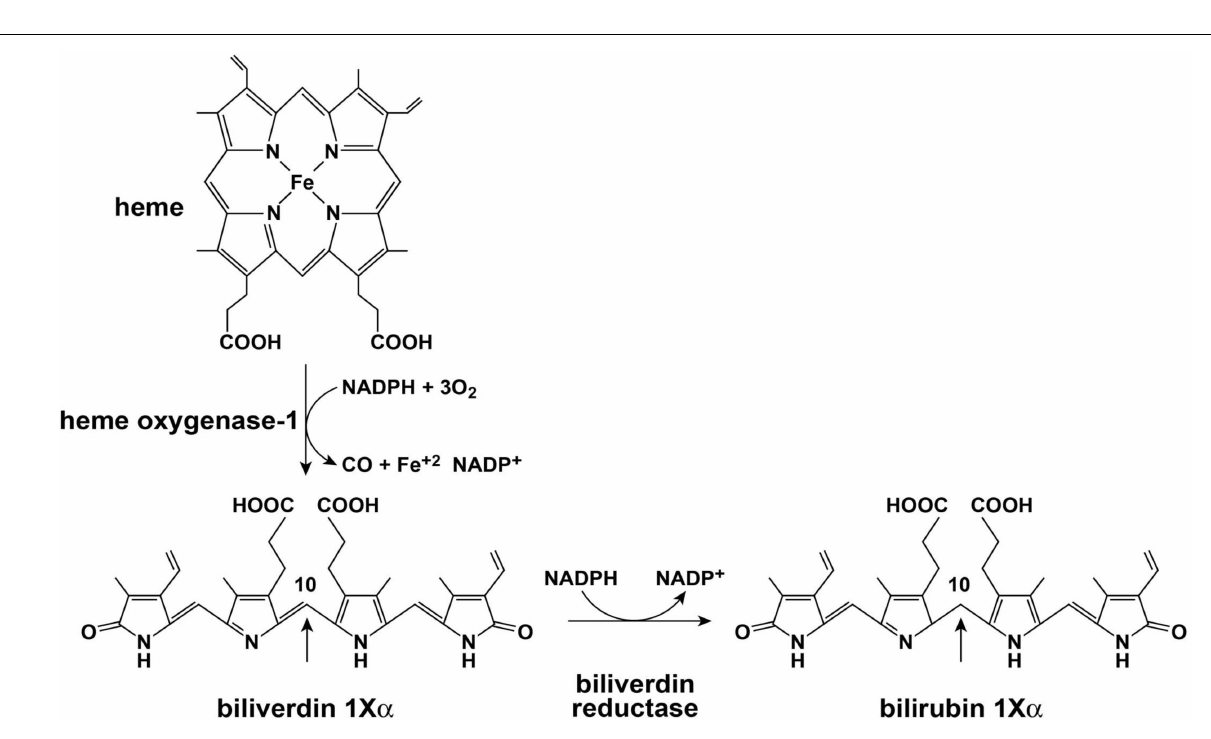
FIGURE 2 | Heme oxygenase and biliverdin reductase